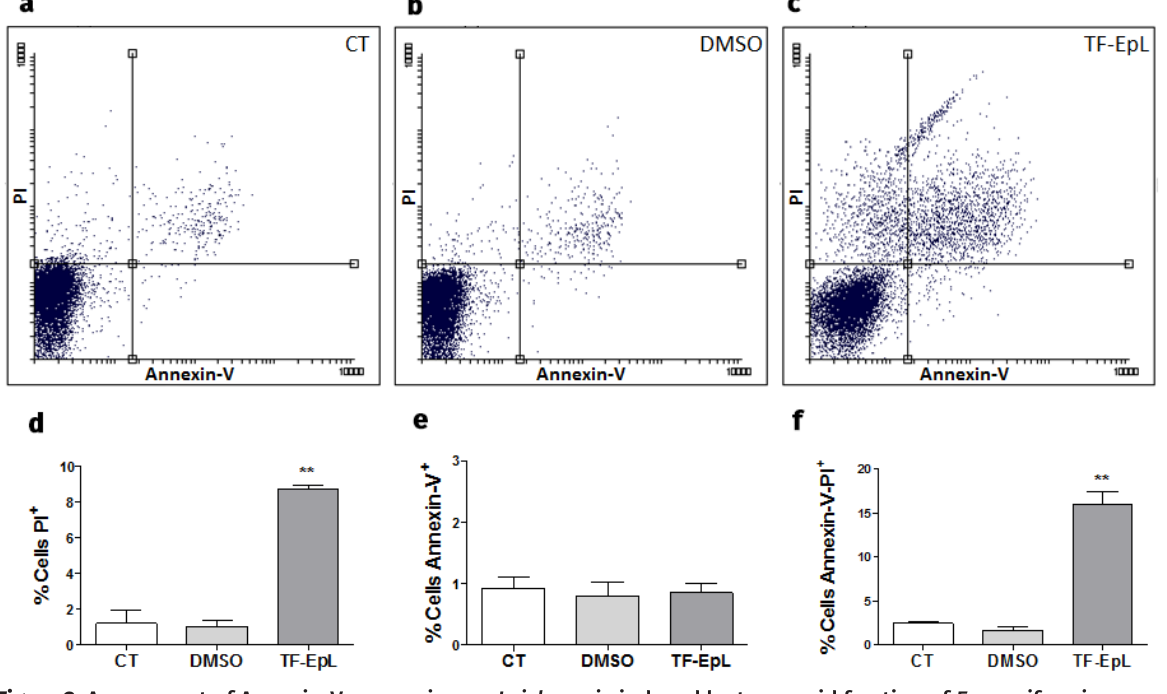
Figure 3. Assessment of Annexin-V expression on Leishmania induced by terpenoid fraction of E. pruniformis leaves (TF-EpL) treatment. Promastigotes were treated or not with TF-EpL and the expression of Annexin-V / Propidium Iodide (PI) measured. Untreated parasites control (a), parasites treated with 1 % DMSO (b) and 43.60 μg/mL TF-EpL (c) are shown as a representative result out of 3 independent experiments with similar results. The percentage of PI positive (d), Annexin-V positive (e) and Annexin-V-PI positive promastigotes (f), treated as above, shown as mean ± SEM of 3 independent experiments. p < 0.001 (**) compared to the